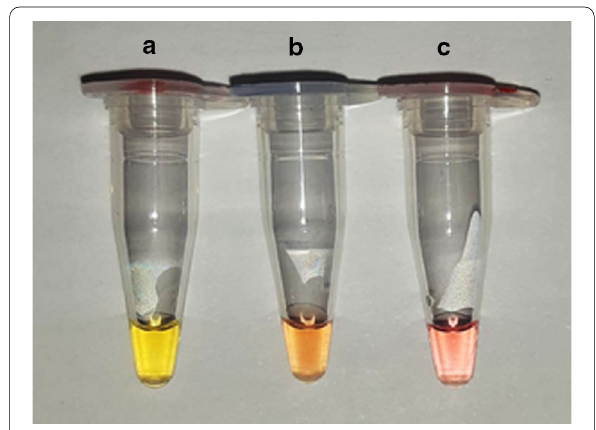
Fig. 1 Colorimetric RT-LAMP color display. Tube ( a ) positive ( b ) intermediate and ( c ) negative. This analysis was made by naked eye as in a real case scenario